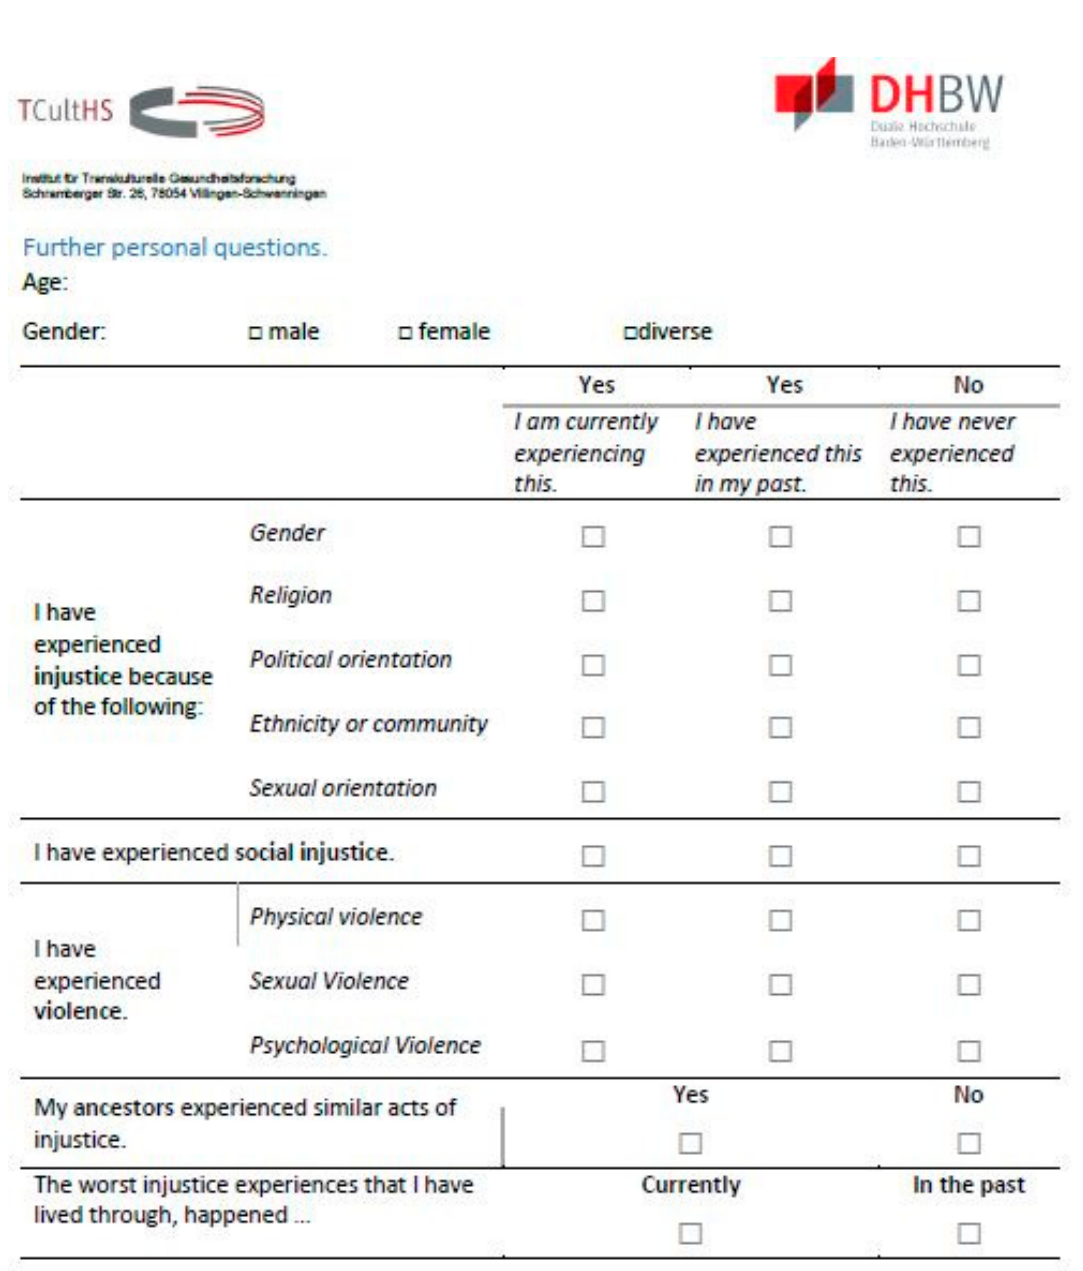
Figure A3. The PIQ, page 3.